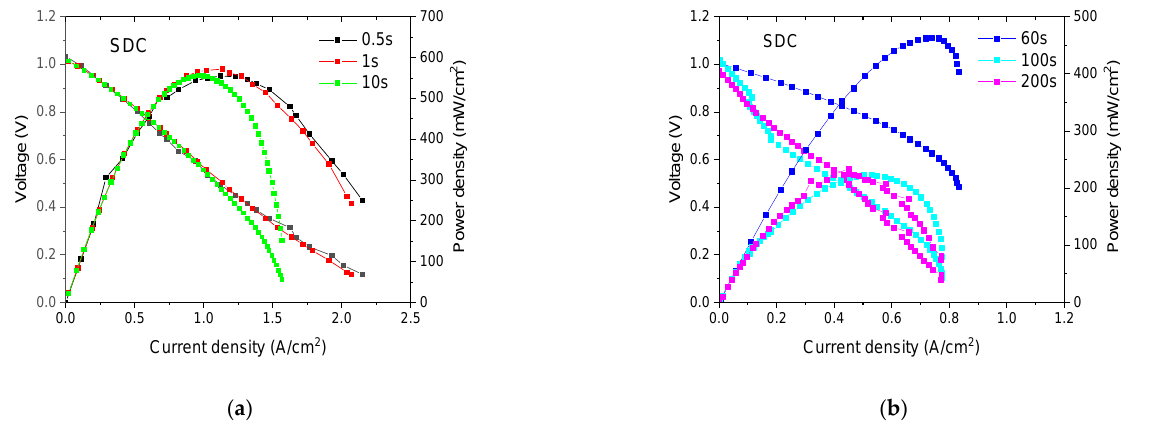
Figure 3. The peak performance curve of SOFCs using SDC electrolyte with ( a ) 0.5–10 s time interval; ( b ) 60–200 s time interval.